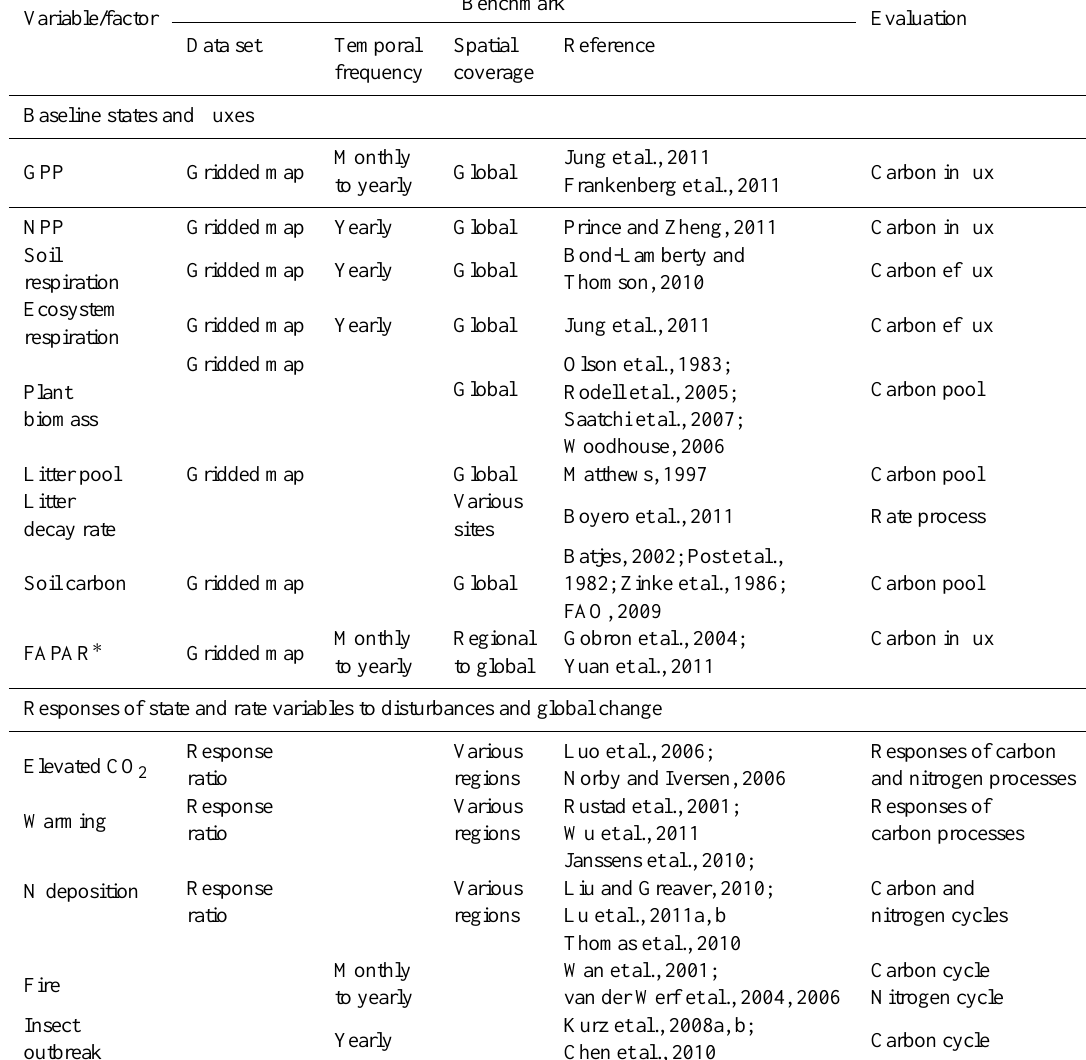
Table 3. Candidate benchmarks to be used to evaluate biogeochemical